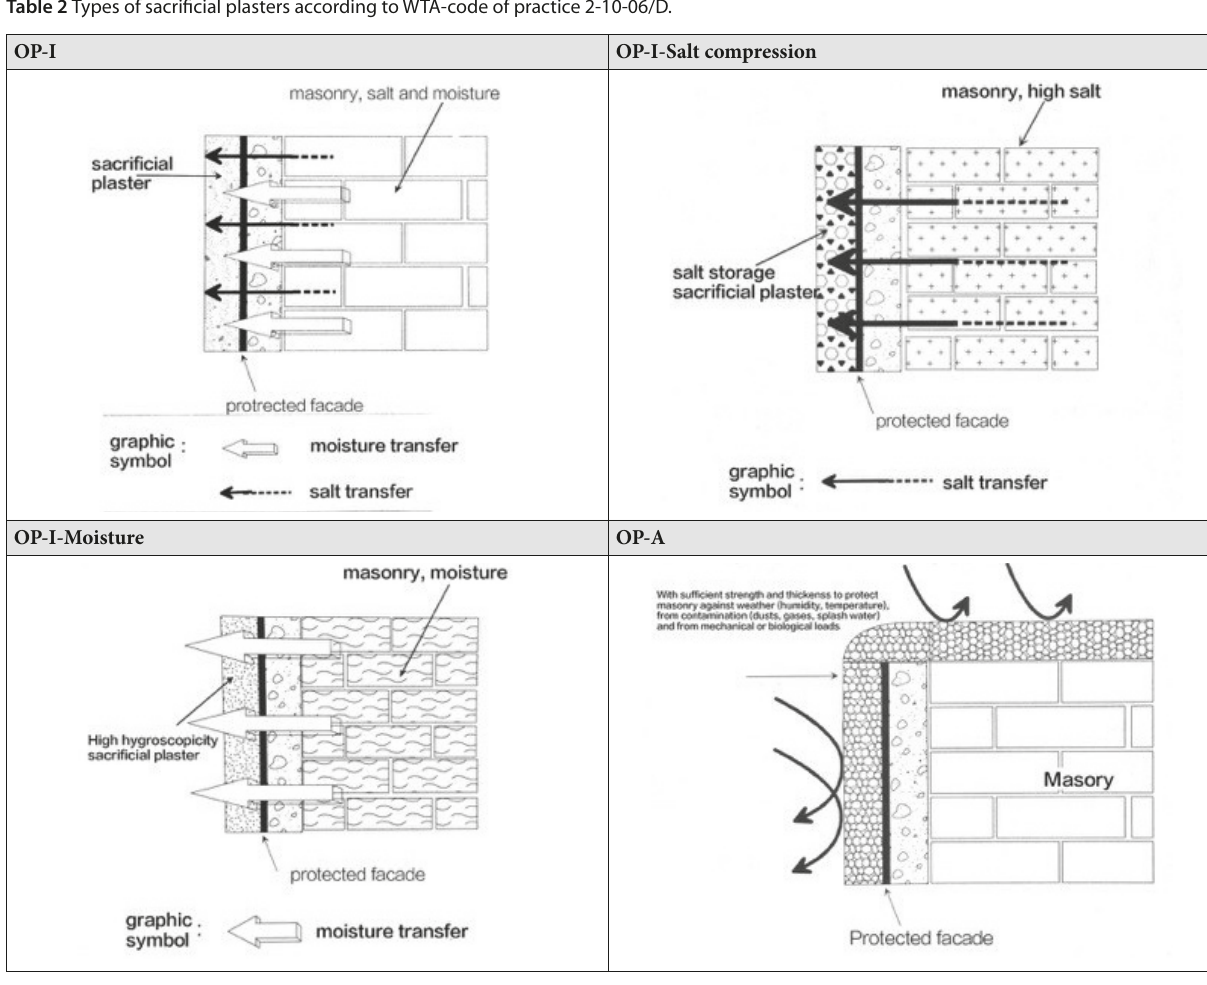
Table 2 Types of sacrificial plasters according to WTA-code of practice